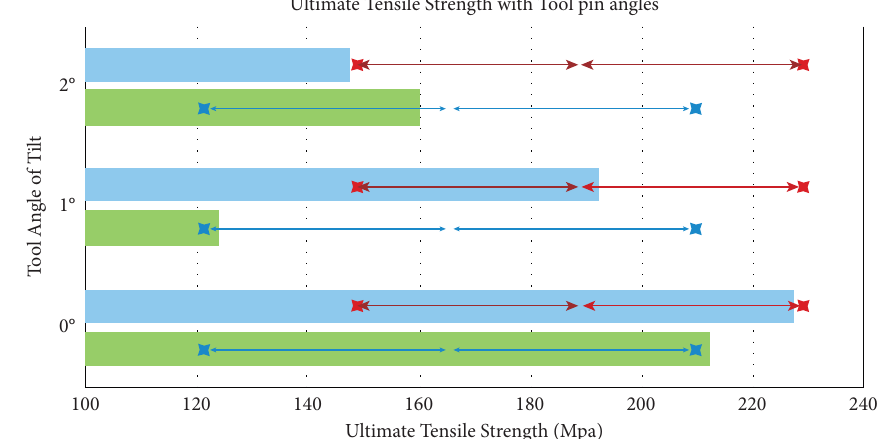
Figure 4: Comparison of ultimate tensile strength with tool pin